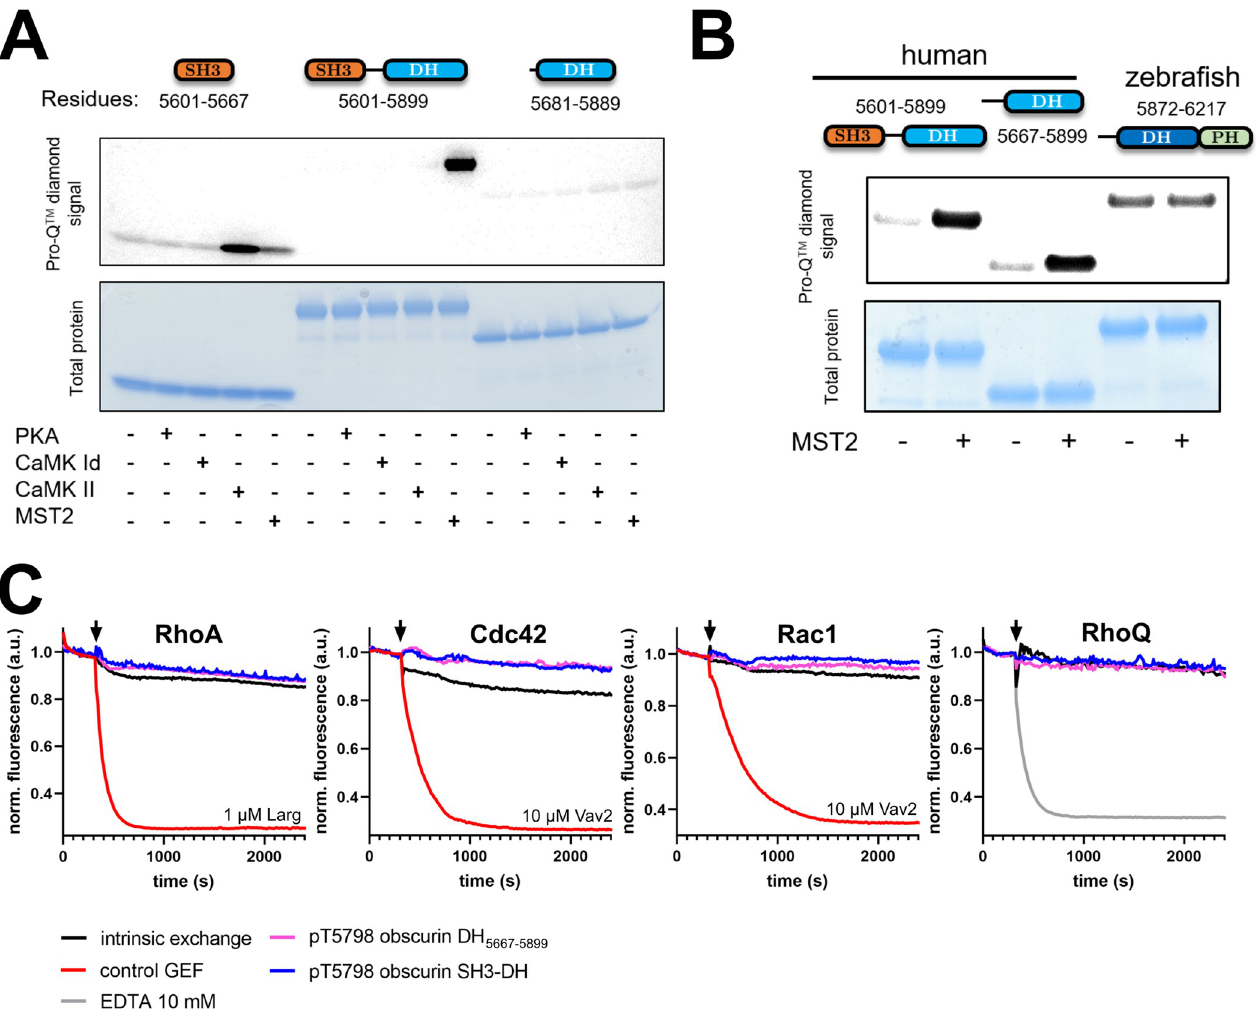
Fig 4. Phosphorylation of obscurin RhoGEF domains. A, phosphorylation of different human obscurin RhoGEF domain combinations by different kinases. B, MST2-phosphorylation of an N- and C-terminally extended human DH domain and a zebrafish DH-PH fragment compared to human SH3-DH. C,